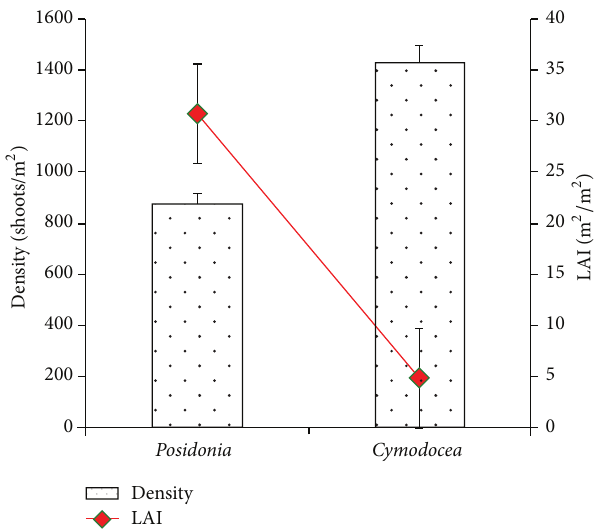
Figure 2: Average leaf area index (LAI) and shoot density of P. oceanica and Cymodocea